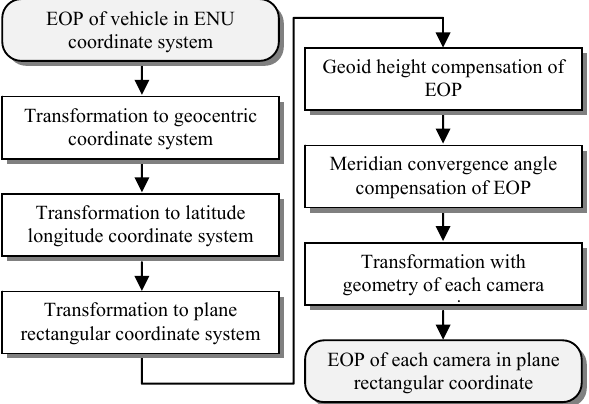
Figure 8. Procedure to calculate EOP of each